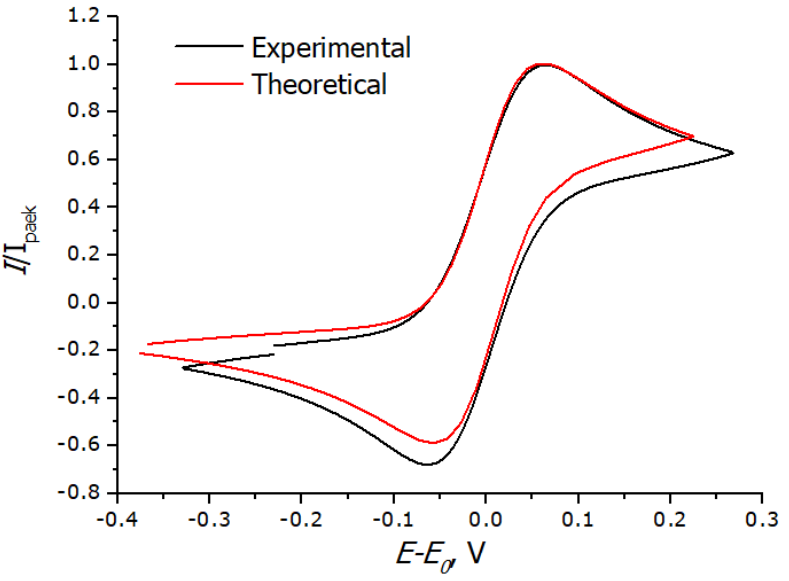
Figure 14. Theoretical and experimental CV curves of ferrocenemethanol.